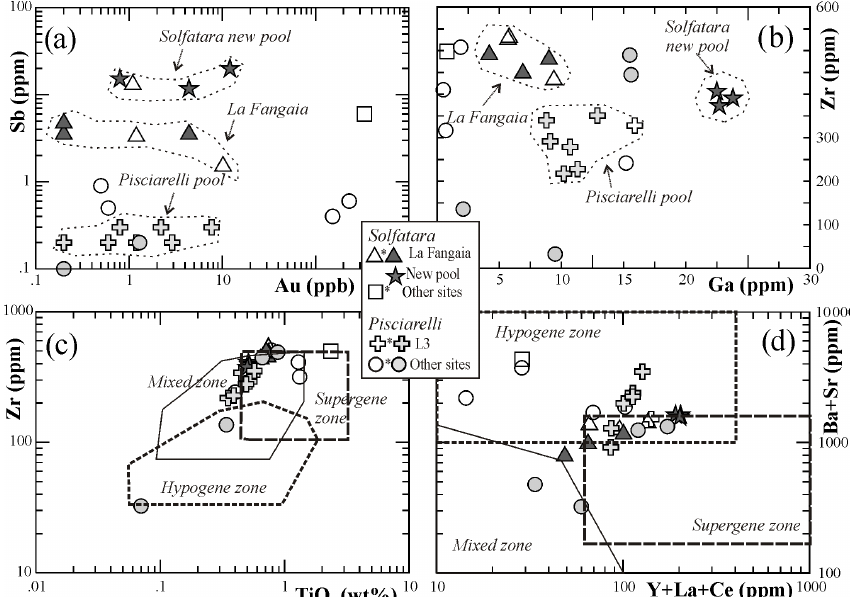
Figure 9. Cross plots of trace elements in solfataric samples. Fields envelop the various genetic settings, following Ercan et al. (2016) and based on the (a) immobile and (b) and mobile elements sourced from K-feldspars (Ba, Sr, Ce, Y, La), in an initially alteration-undersaturated geothermal solution. Note the logarithmic scale in (a) , (c) and (d)